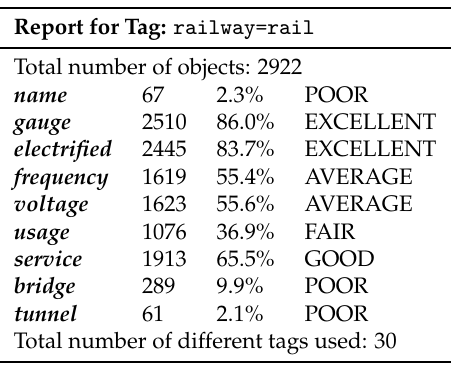
Table 3. The compliance of objects with the suggested tagging in the OSM Map Features wiki page for the target tag railway=rail is shown for Warsaw,